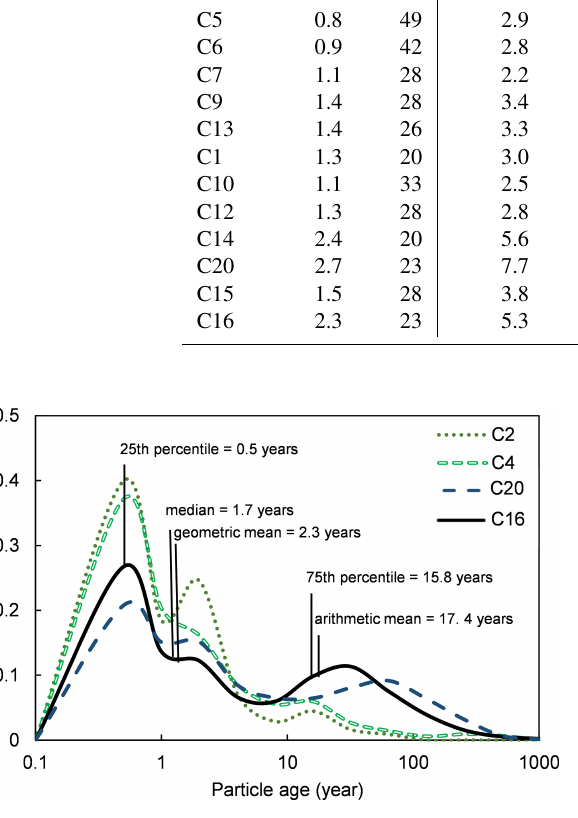
Figure 5. Examples of particle-tracking results. The figure shows the distribution of all particles reaching the different streams for the entire modelling period. The solid line shows the statistics for C16, including the 25th percentile, the median, the geometric mean, the arithmetic mean, and the 75th percentile (Appendix A). More- over, the figure shows three other example distributions, including C2 (small forest- and till-dominated catchment), C4 (small mire- dominated catchment), and C20 (small silt-dominated